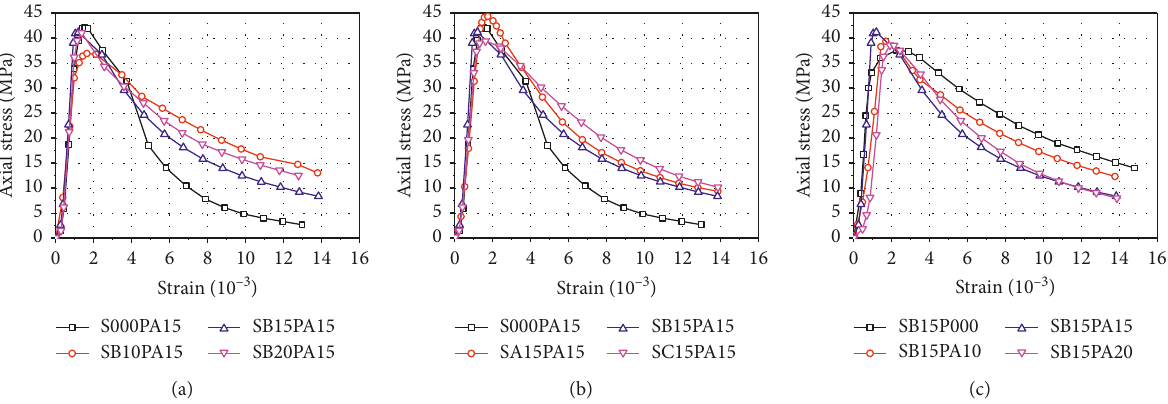
Figure 5: Cyclic envelope curves of HFRC: (a) effect of volume fraction of SF; (b) effect of aspect ratio of SF; (c) effect of volume fraction of